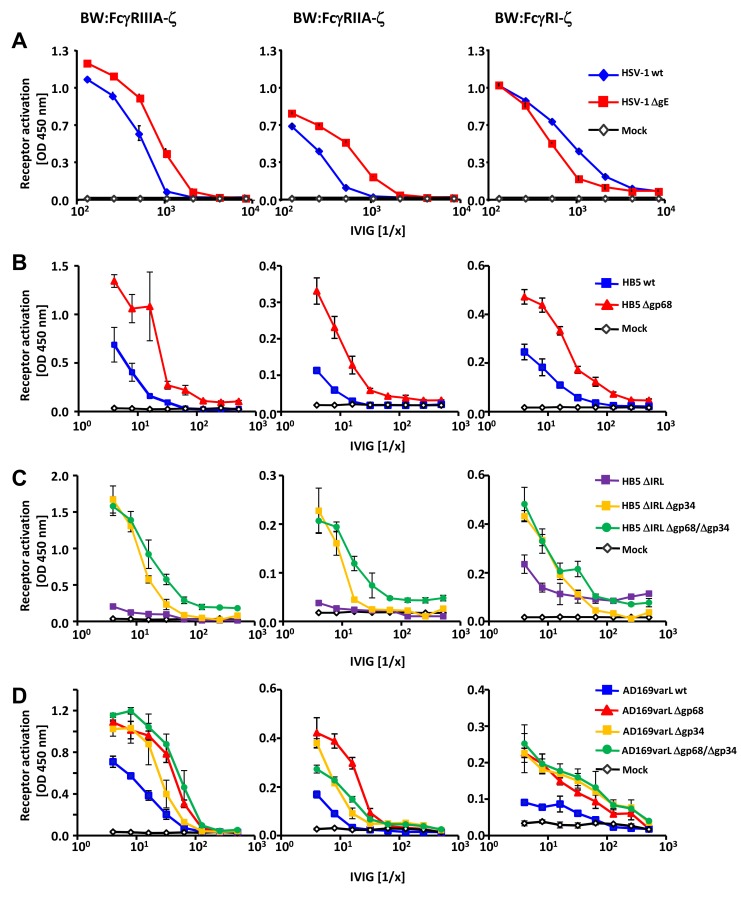
HSV-1 gE, HCMV gp68 and HCMV gp34 interfere with host FcγR activation upon opsonization of cells with polyclonal immune IgG.(A) The HSV vFcγR gE inhibits FcγRIIIA and FcγRIIA activation but fails to inhibit FcγRI. Human MRC-5 fibroblasts were infected with 2 PFU/cell of HSV-1 strain F wt and ΔgE for 24 h. Cells were opsonized with Cytotect at different concentrations for 30 min. After removing of unbound antibodies with D-MEM 10% (vol/vol) FCS, 1×105 BW:FcγR-ζ transfectants per well were added and co-cultivated overnight. BW:FcγR activation was determined by measuring mIL-2 by ELISA. Three independent replicates were measured; means with standard deviations (error bars) are shown for 4 independent experiments. (B) HCMV vFcγR gp68 interferes with FcγRIIIA, FcγRIIA and FcγRI activation. MRC-5 cells were infected with HCMV HB5 wt virus or HB5Δgp68 (2 PFU/cell) for 72 h. Fibroblasts were opsonized with Cytotect at different concentrations for 30 min. After removing of unbound antibodies by washing, 1×105 BW:FcγR-ζ transfectants were added per well. Measurement of mIL-2 in supernatants after 16 h of co-cultivation of reporter cells with targets was performed by ELISA. Values are presented in the graphic as OD 450 nm. Three independent wells were measured; means with standard deviations (error bars) are shown for 4 independent experiments. Significance of results (Student's t-test) are presented in Table S1 as *: p<0.05 **: p<0.01 ***: p<0.001. (C) HCMV vFcγR gp34 interferes with FcγRIIIA, FcγRIIA and FcγRI activation. As in (B) but MRC-5 cells were infected with HCMV HB5ΔIRL, HB5ΔIRLΔgp34 or HB5ΔIRLΔgp68/Δgp34 (2 PFU/cell) for 72 h. (D) gp34 and gp68 interfere with FcγR activation in AD169varL infected cells. As in (B) but MRC-5 cells were infected with AD169varL wt, AD169varLΔgp68, AD169varLΔgp34 or AD169varLΔgp68/Δgp34.